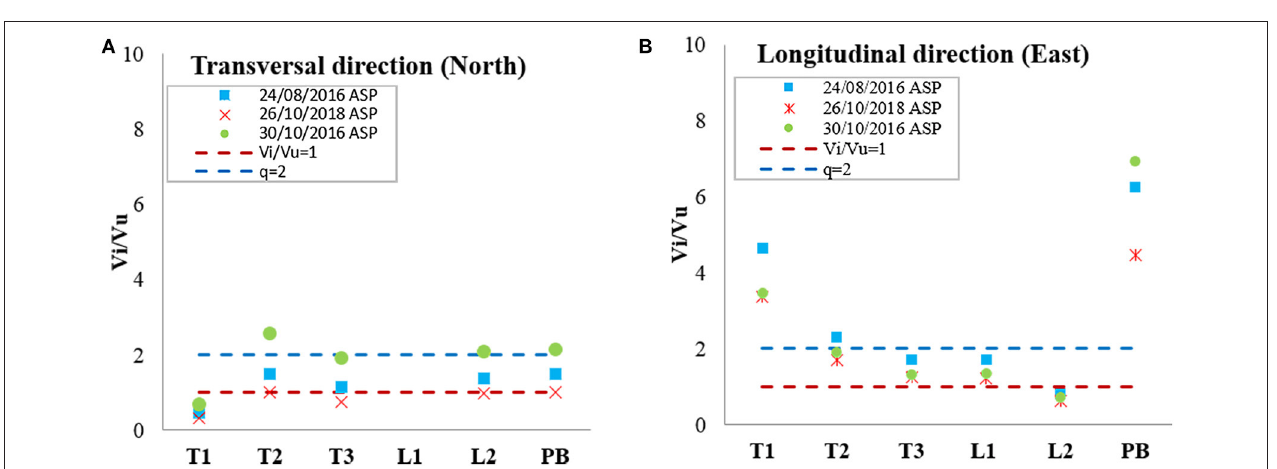
Model CS , i.e., actual state, considering elastic spectra of the